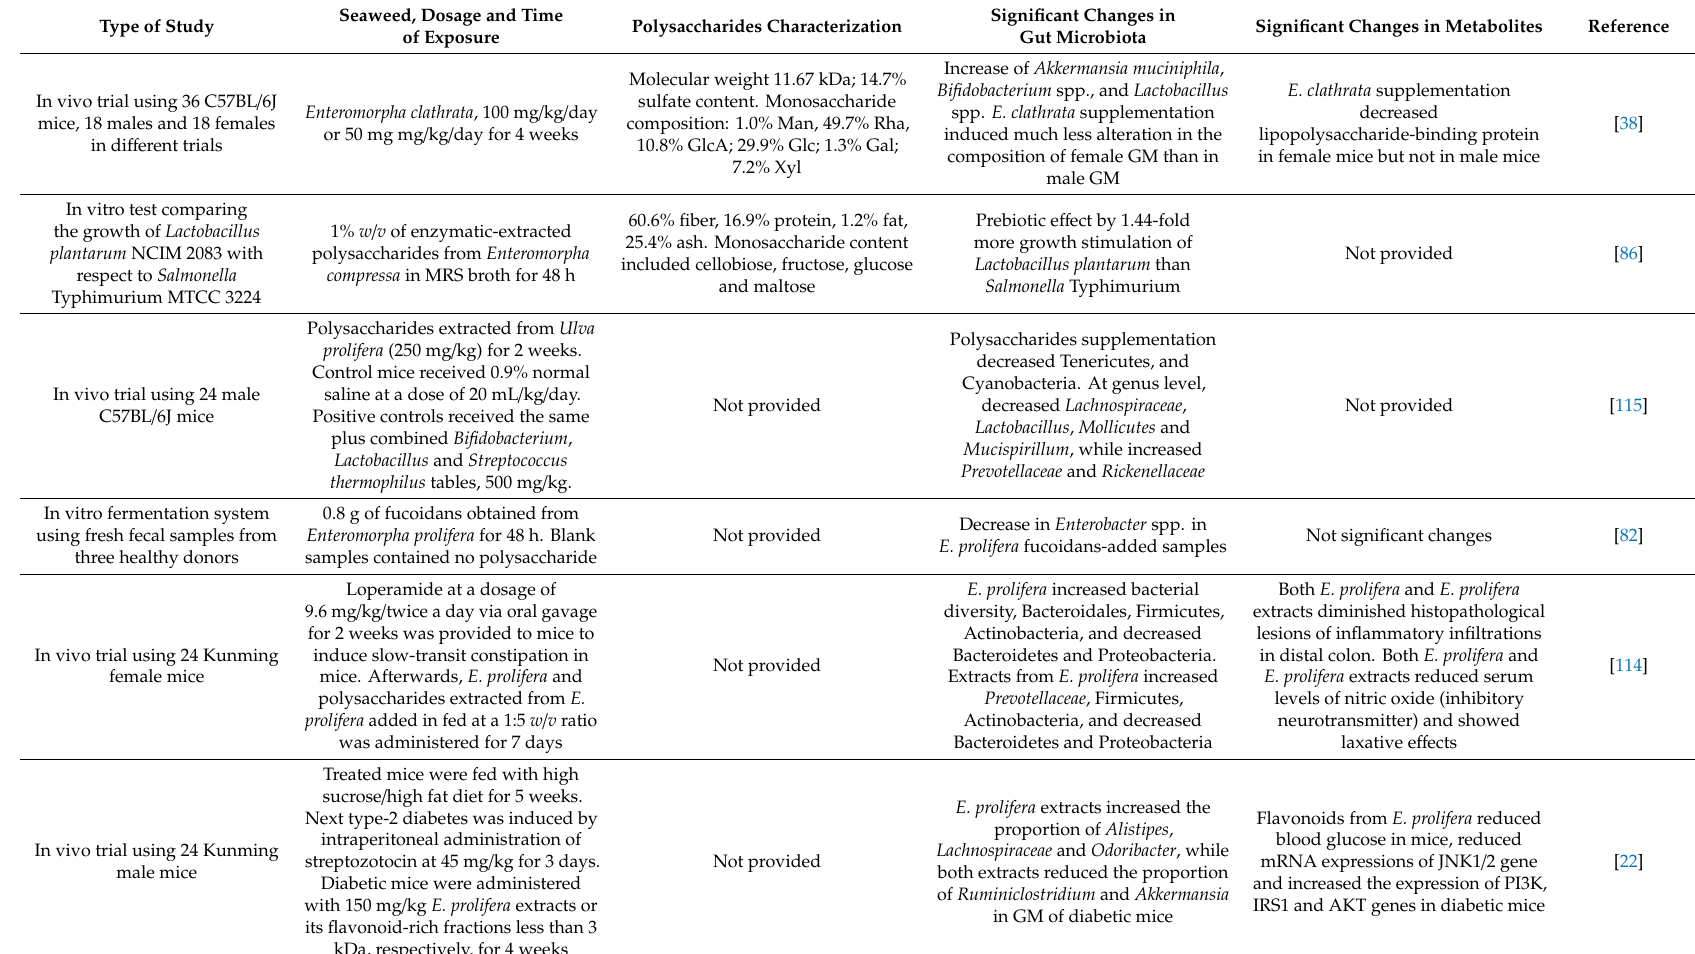
Table 3. Prebiotic e ff ect of di ff erent species of green